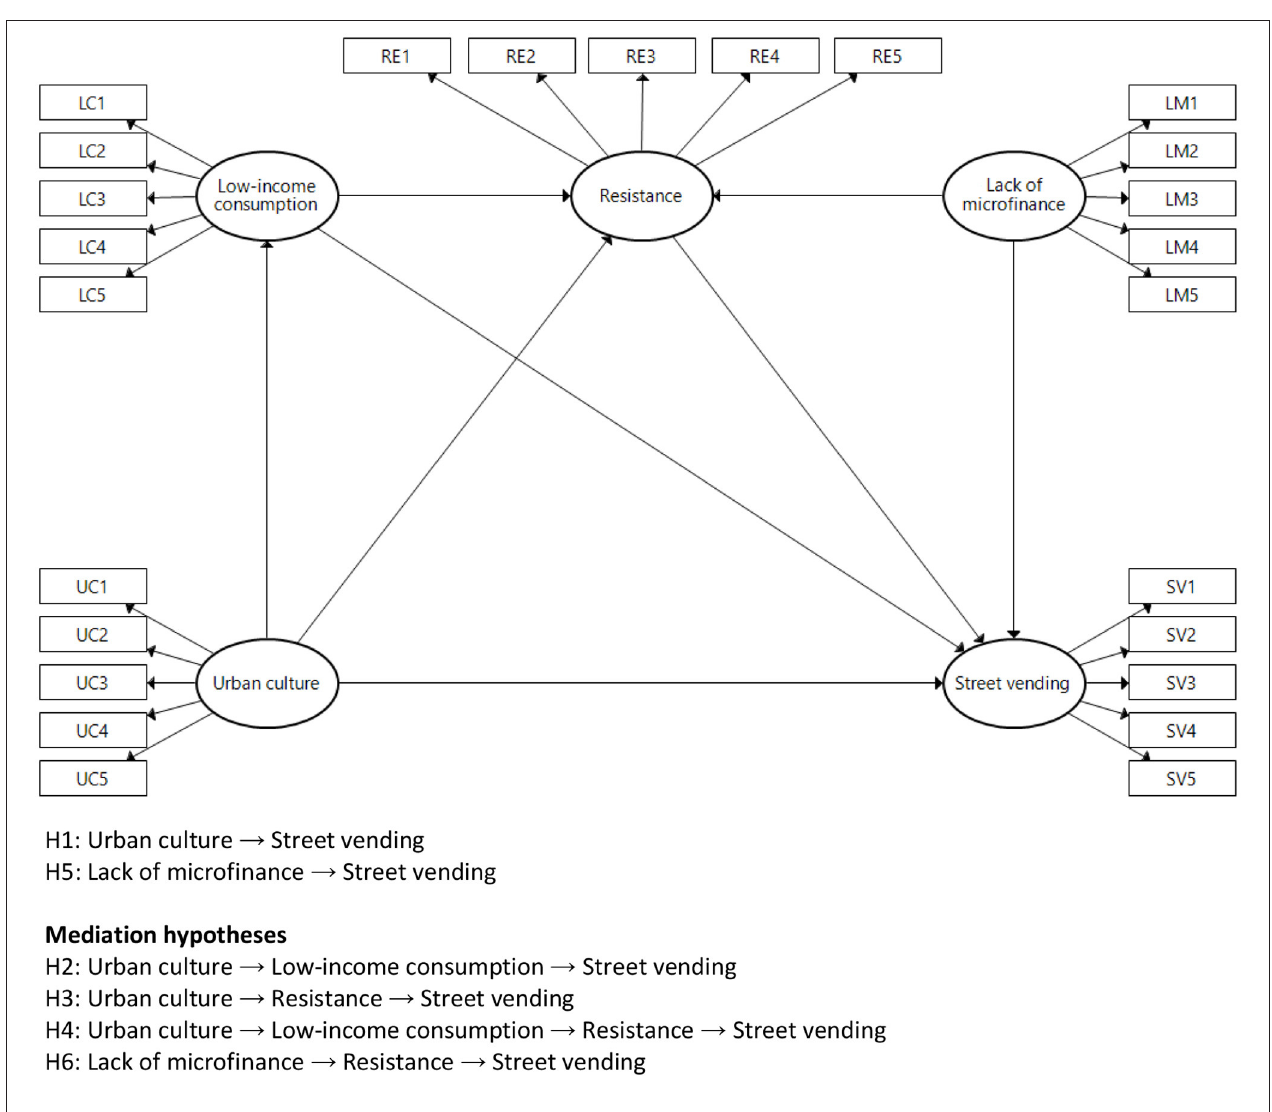
FIGURE 1 | Conceptual research